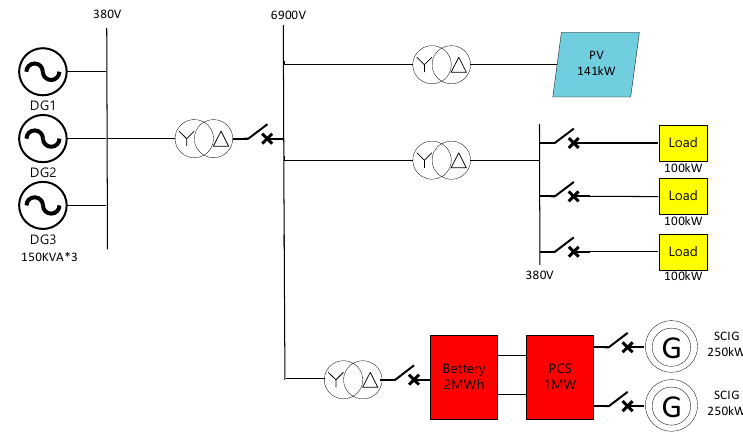
Figure 1 . The existing Gapado Island Power Grid . Figure 1. The existing Gapado Island Power